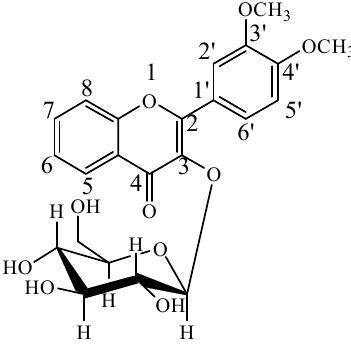
Figure 1. Chemical structure of DF3G